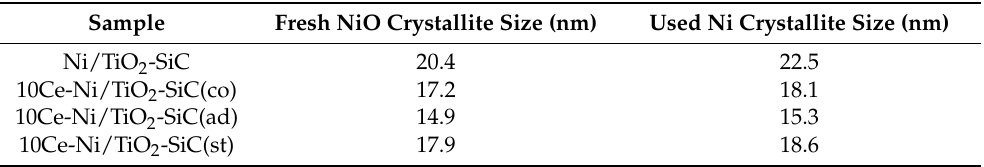
Table 2. Crystallite size calculated by the Scherrer